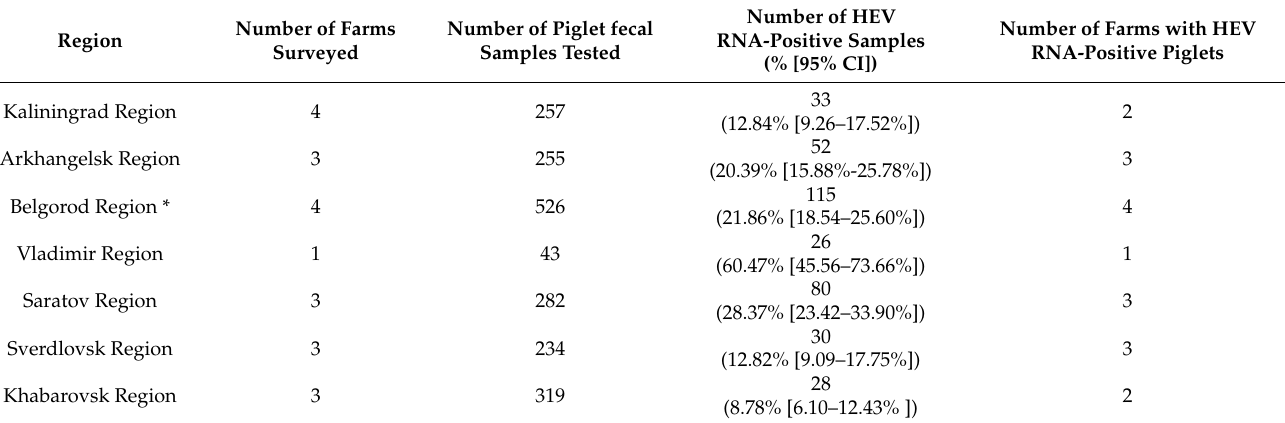
Table 3. Rates of HEV excretion in piglets aged between 2 and 4 months.